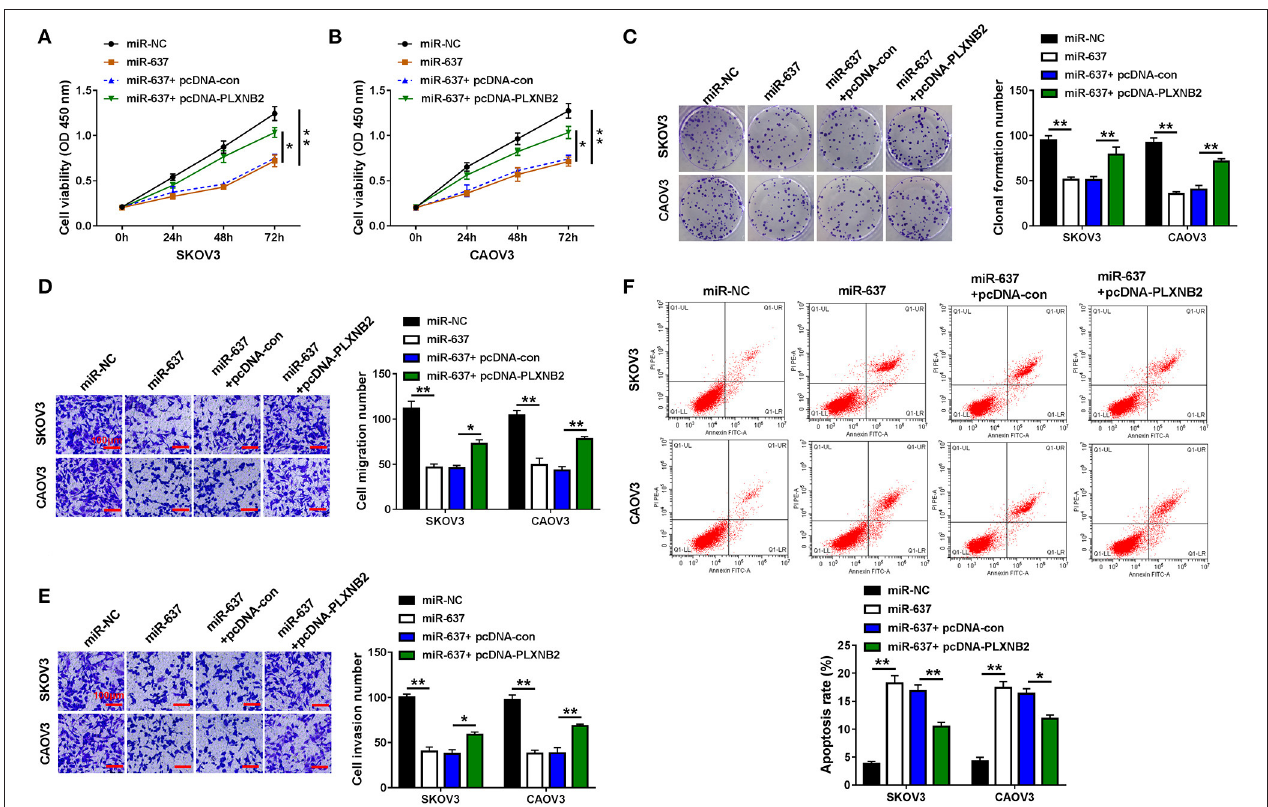
FIGURE 5 | MiR-637 exerted a tumor-repressor role in OC by targeting PLXNB2. SKOV3 and CAOV3 cells were transfected with miR-NC, miR-637, miR-637 + pcDNA-con, or miR-637 + pcDNA-PLXNB2, respectively. (A,B) CCK-8 assay for the cell viability of transfected cells. (C) Colony formation assay for the clonogenicity ability of transfected cells. (D,E) Transwell assay for the cell migration and invasion in transfected cells. The scale bar represents 100 µ m. (F) Flow cytometry for the apoptosis rate of transfected cells. * P < 0.05; ** P < 0.01.